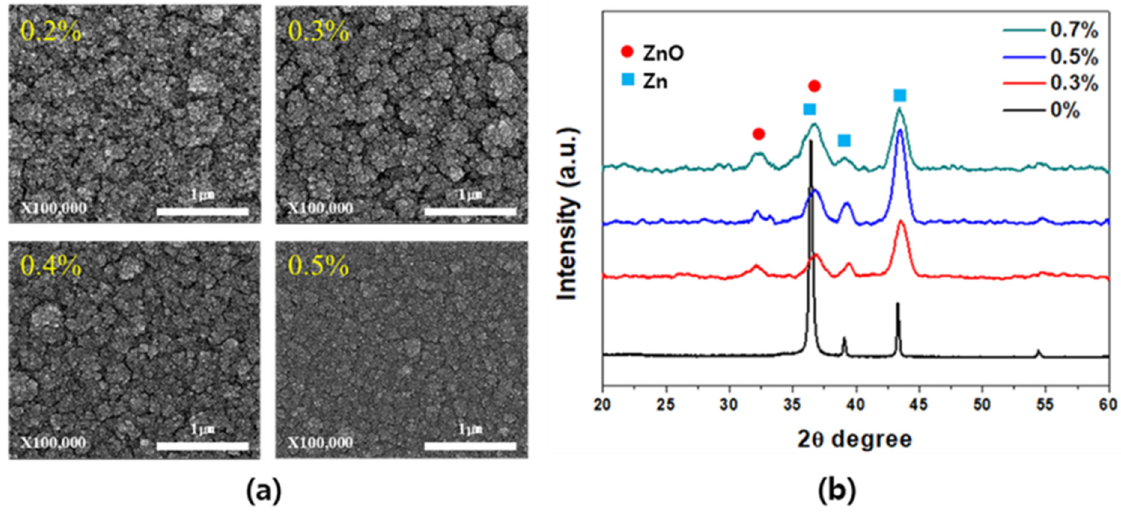
Figure 2. ( a ) Surface SEM images and ( b ) XRD patterns of the formed Zn and ZnO films upon variation in the O 2 ratio.